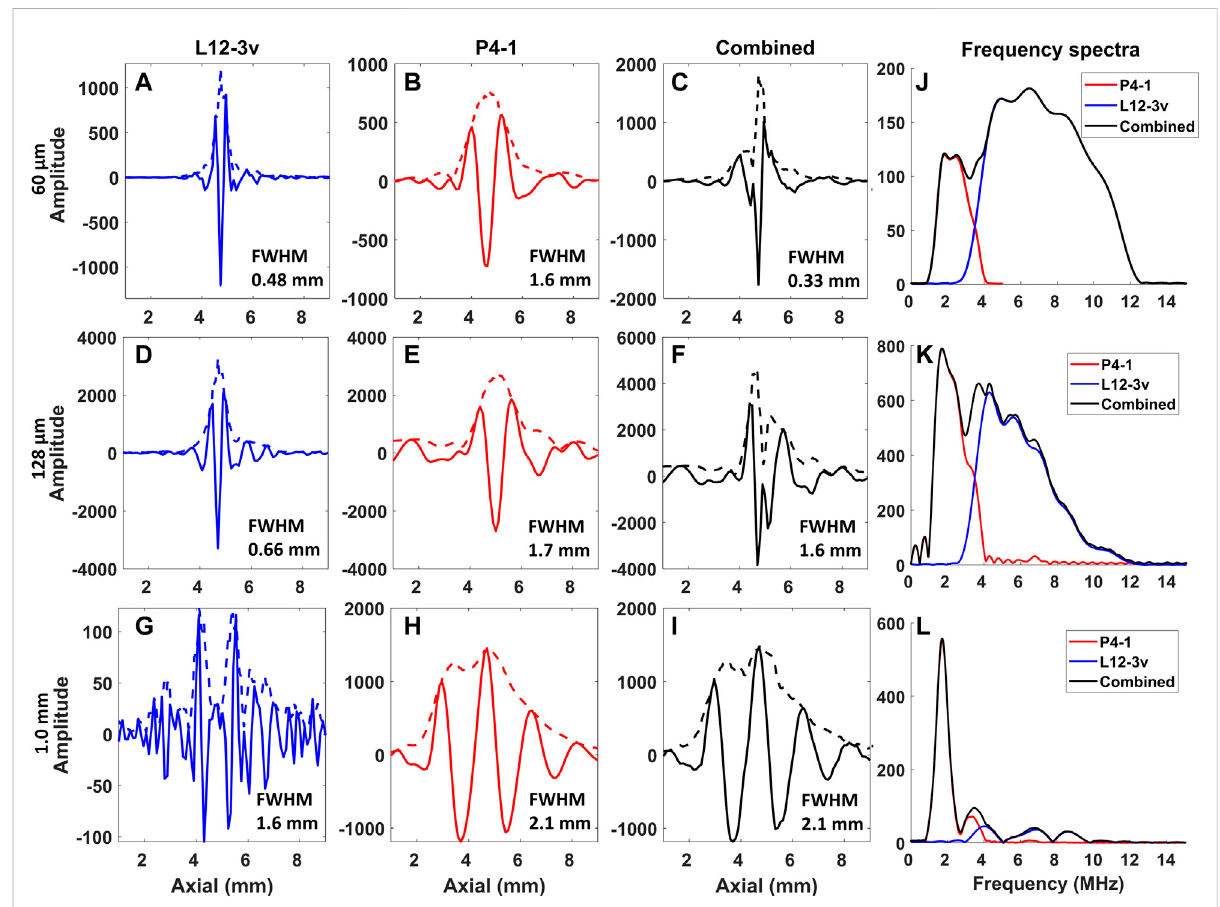
FIGURE 7 Axial pro fi les of the PA raw RFsignal and corresponding frequency spectraacquired from the wire targets. Along thecolumns the L12-3v, P4-1, combined, and frequency spectra are displayed. Along the rows, the pro fi le and frequency spectra of the 60 μ m (A – C,J) , 128 μ m (D – F,K) , and 1.0 mm (G – I,L) wire targets are displayed. The dotted line in fi g (A – I) indicates the envelope of the pro fi